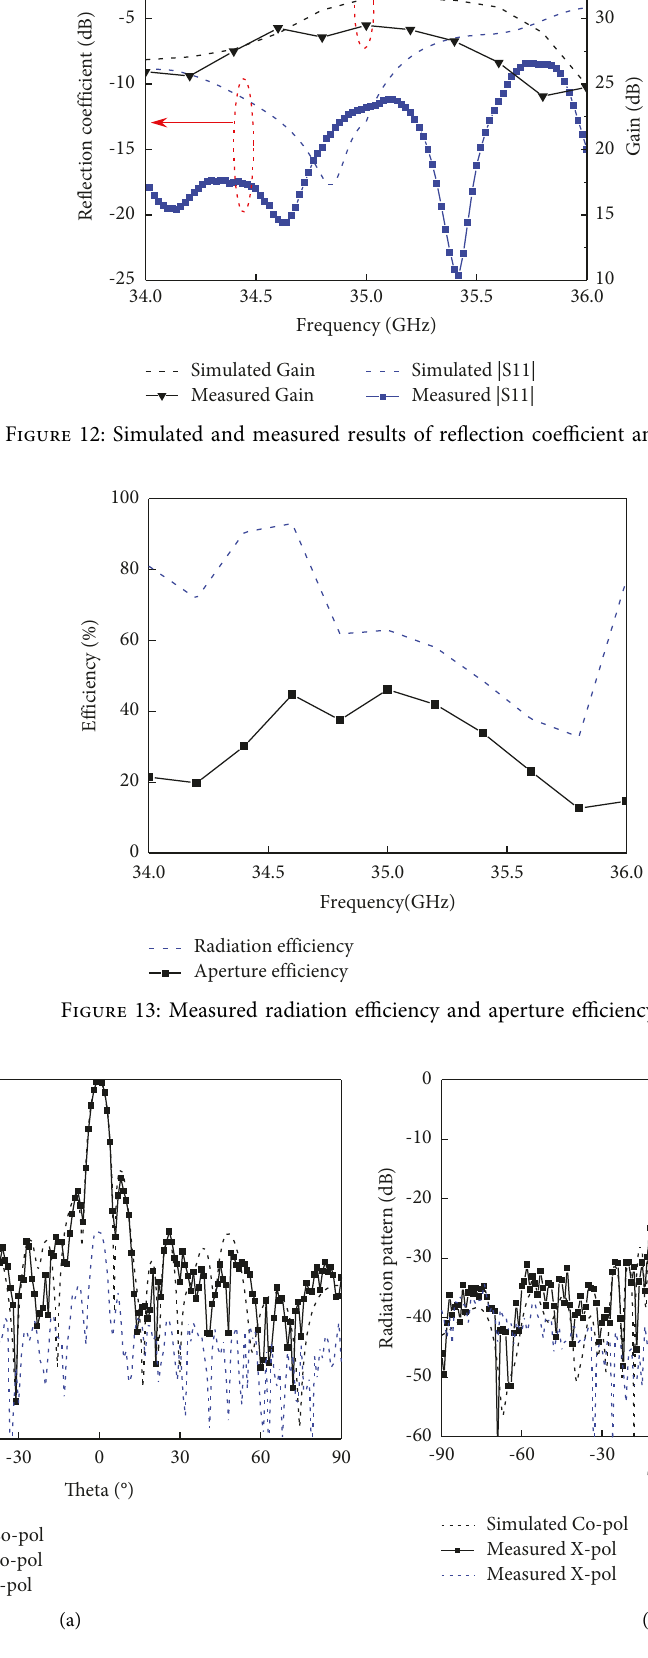
Figure 14: Normalized radiation patterns at 35 GHz. (a) E-plane. (b)